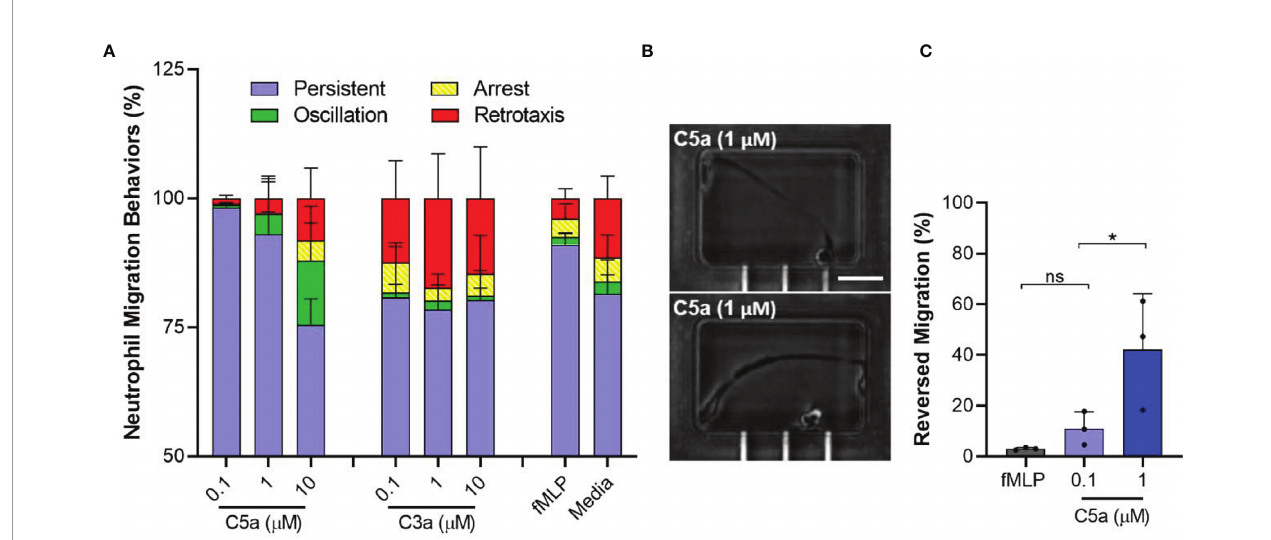
FIGURE 3 | Atypical membrane elasticity of neutrophils and migration patterns when exposed to high C5a dose. (A) Percentage of neutrophil migration patterns during chemotaxis towards C5a, C3a, and fMLP. (N=3). (B) Microscopic images of elongated neutrophils when exposed to C5a 1µM inside the end chambers. Scale = 100 µm. (C) Percentages of unique reversed migration phenotype of neutrophils observed when exposed to high C5a concentration. (N=3, *p < 0.05; ns represents not statistical signi fi cant. One-way ANOVA with Dunnett ’ s